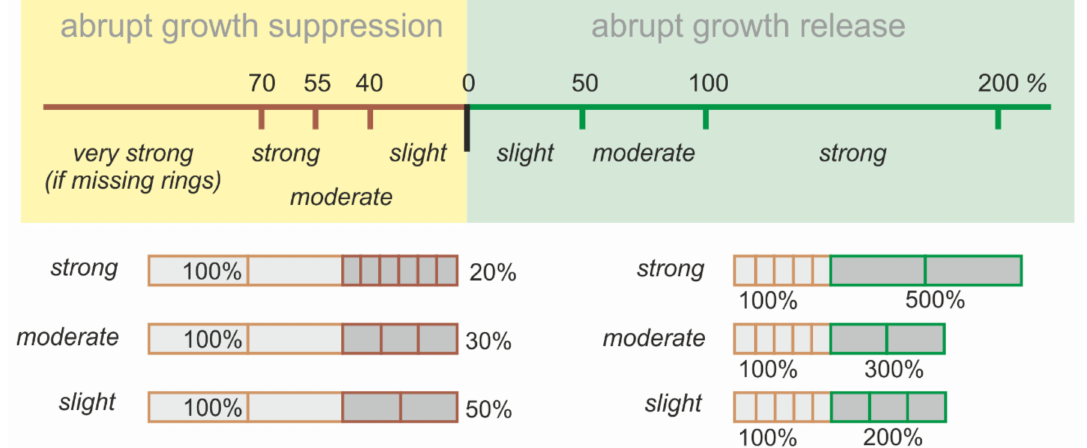
Figure 2. The principle of abrupt growth changes (suppression or release) detection in tree-ring series as a landslide dating approach (adapted after [74]).